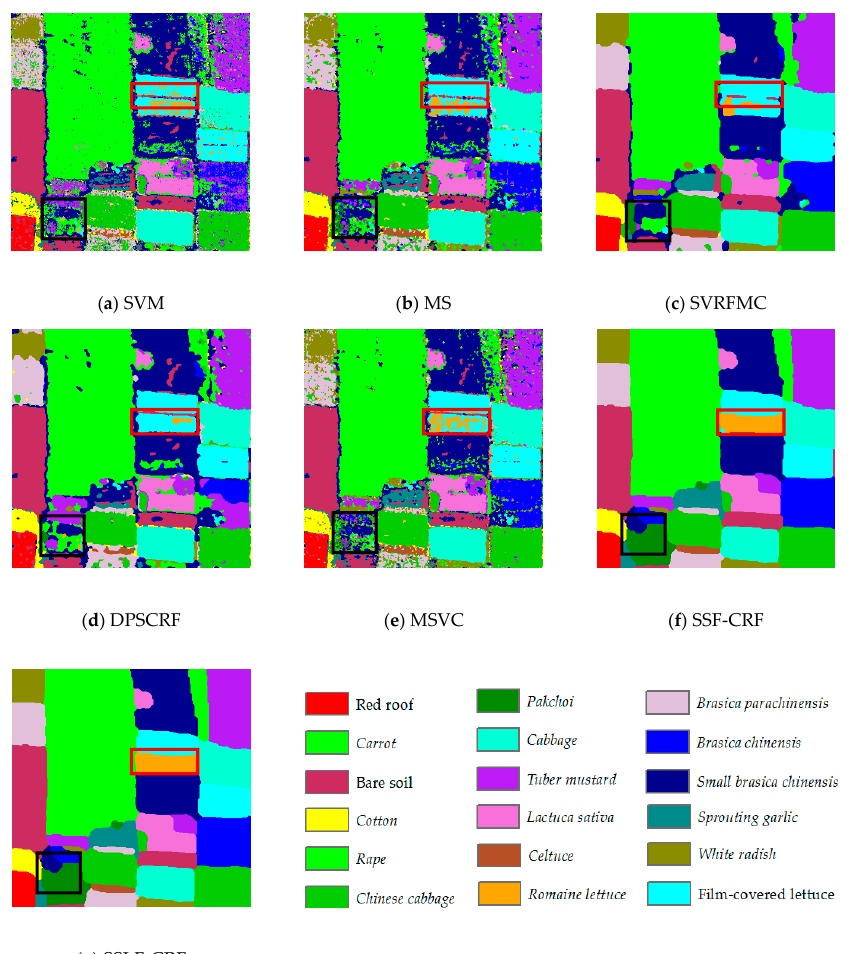
Figure 8. Honghu dataset classification results: ( a ) SVM; ( b ) MS; ( c ) SVRFMC; ( d ) DPSCRF; ( e ) MSVC;